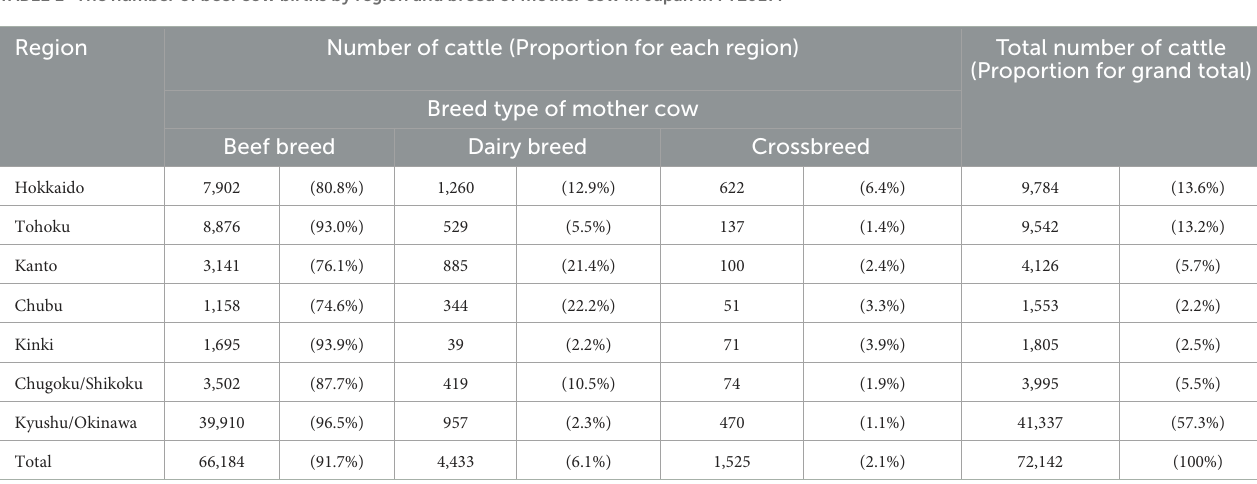
(Proportion for grand total)